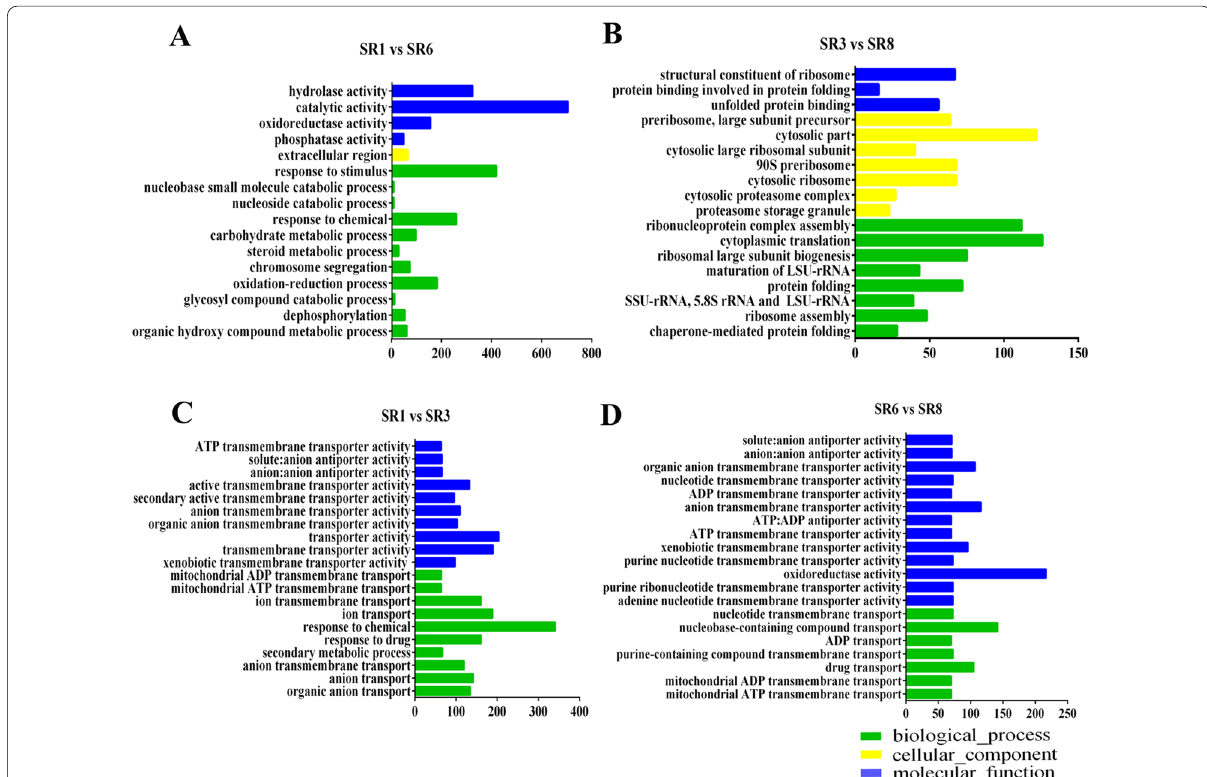
Fig. 3 GO functional classification of differentially expressed genes. A – C and D GO enrichment between different treatments. The green bars represent biological processes; yellow bars represent cellular components; and blue bars represent molecular functions. Only the significant GO terms (P < 0.005) were